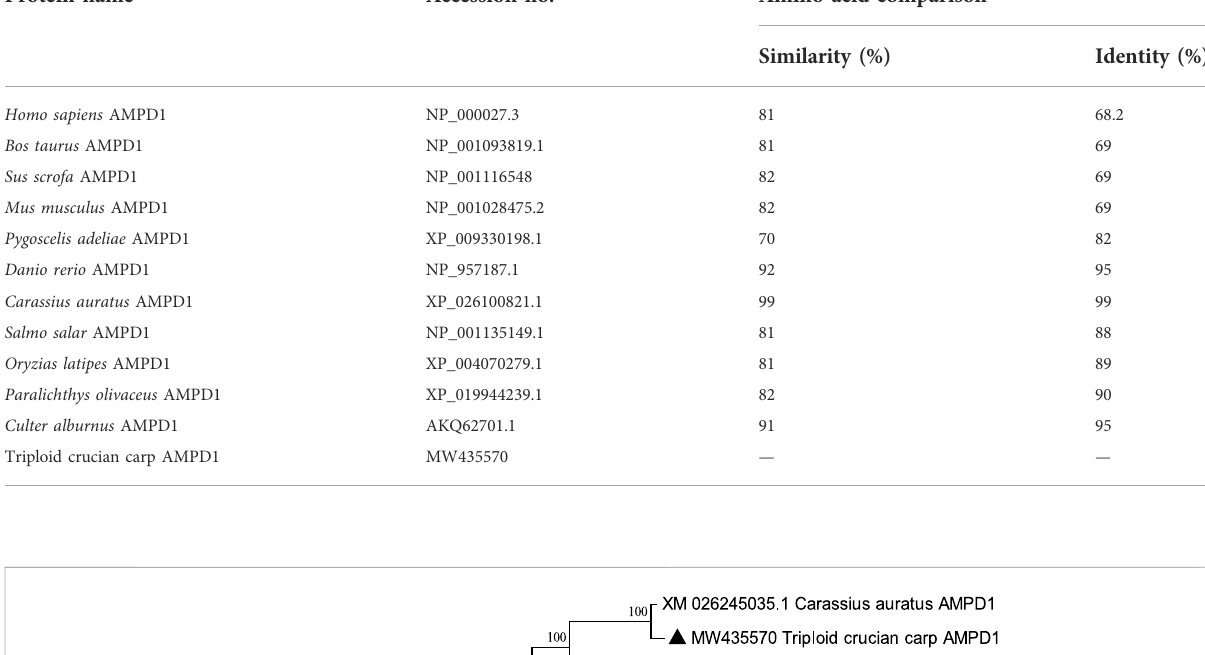
TABLE 3 The amino acid sequence of AMPD1 was compared with that of other species.